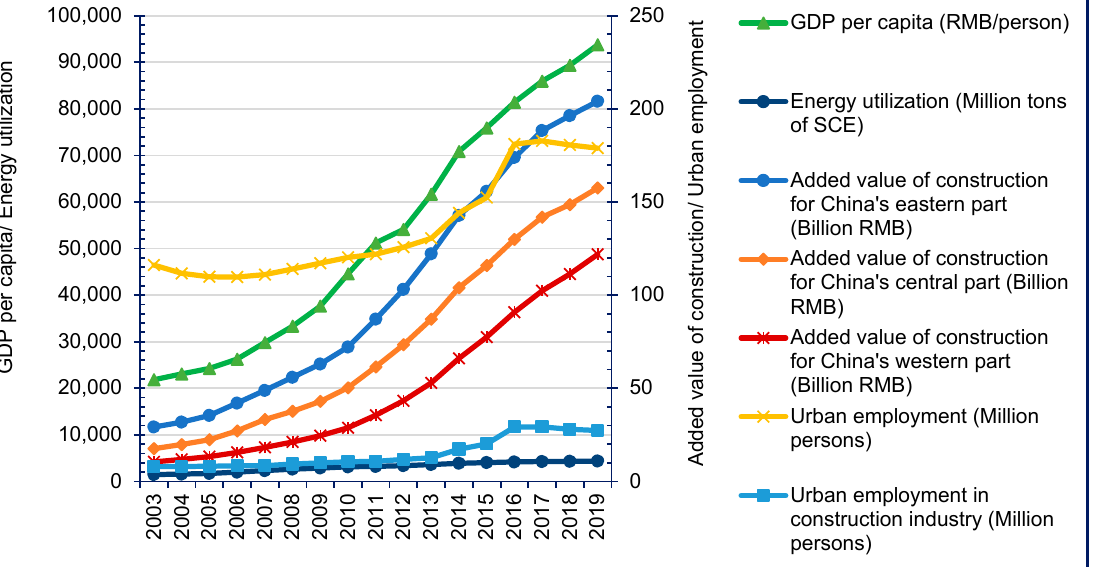
Figure 2. Outlining average trends of the study variables. Source: Authors’ calculations based on China Statistical Yearbooks (2003–2019).